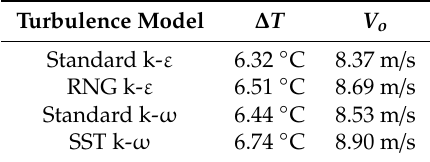
Table 2. Performance comparison of different turbulence models.